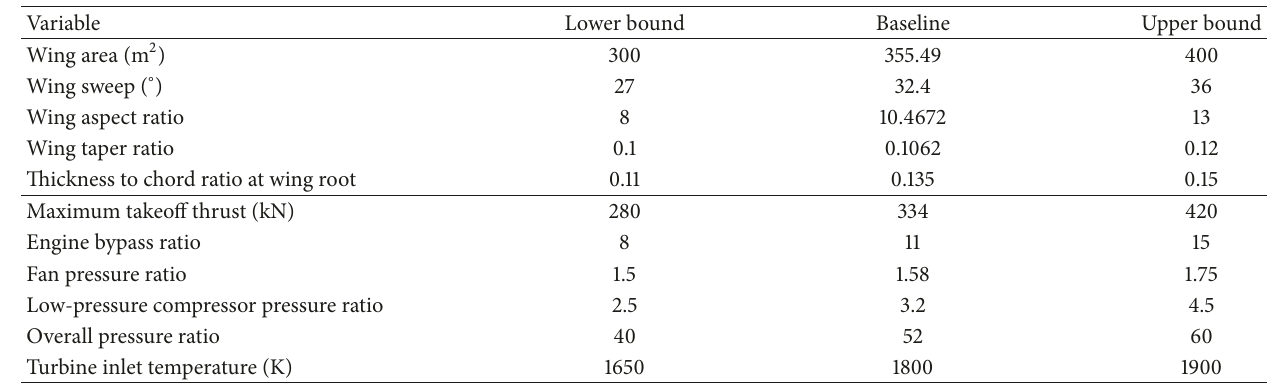
Figure 10: Flow chart of noise prediction program. Table 3: Design variables and their bounds.